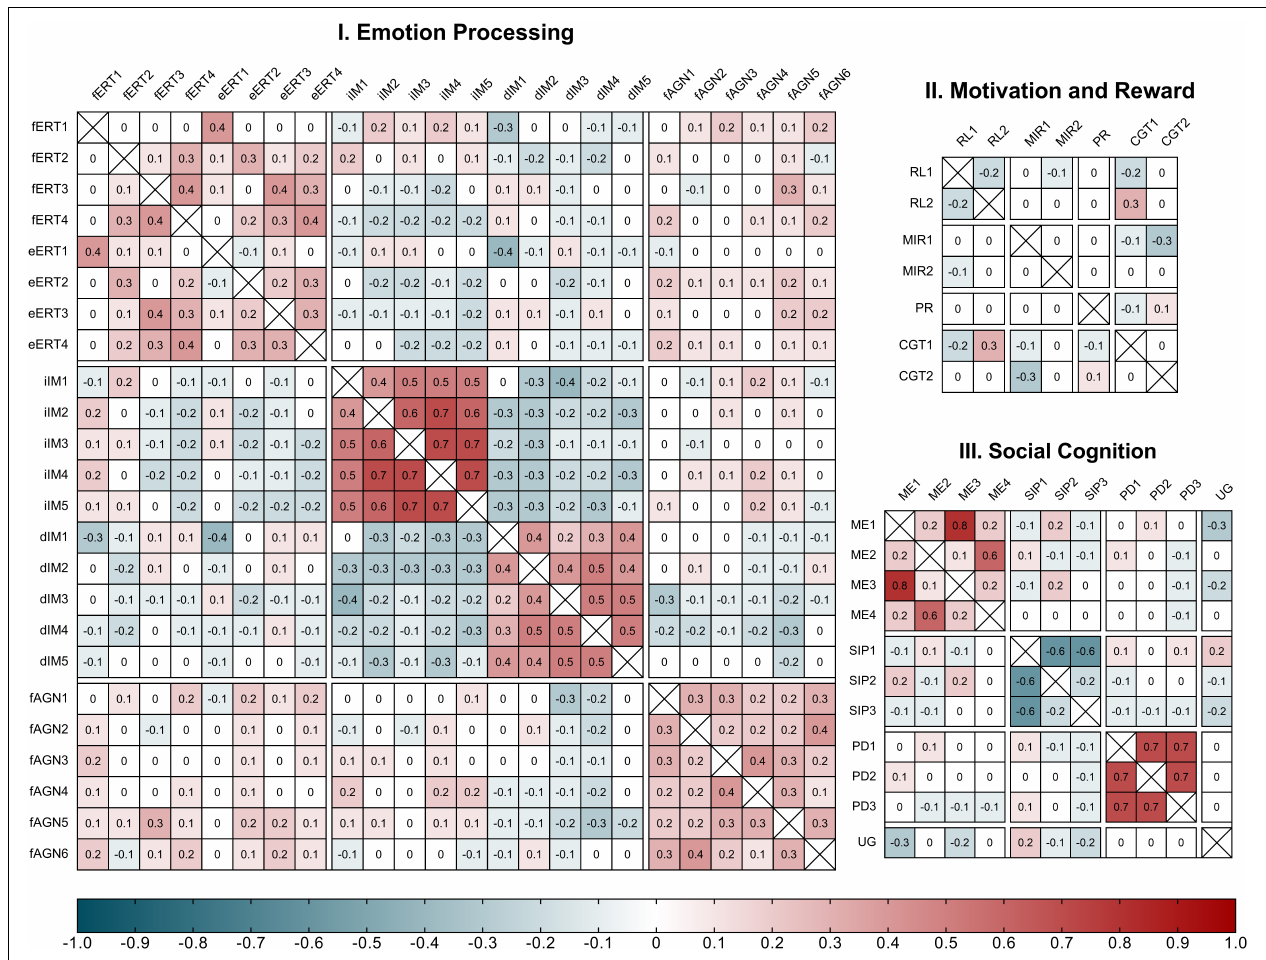
FIGURE 1 | Spearman’s Rank Correlations for EMOTICOM outcomes within the three proposed cognitive domains. (I) Emotion Processing: fERT, face Emotion Recognition Task; fERT1, hit rate for happy; fERT2, hit rate for sad; fERT3, hit rate for angry; fERT4, hit rate for fearful. eERT, eyes Emotion Recognition Task; eERT1, hit rate for happy; eERT2, hit rate for sad; eERT3, hit rate for angry; eERT4, hit rate for fearful. iIM, increase Emotional Intensity Morphing Task; iIM1, detection threshold for happy; iIM2, detection threshold for sad; iIM3, detection threshold for angry; iIM4, detection threshold for fearful; iIM5, detection threshold for disgusted. dIM, decrease Intensity Morphing Task; dIM1, detection threshold for happy; dIM2, detection threshold for sad; dIM3, detection threshold for angry; dIM4, detection threshold for fearful; dIM5, detection threshold for disgusted. fAGN, Face Affective Go/NoGo Task; fAGN1, d-prime for ‘happy/neutral’; fAGN2, d-prime for ‘happy/sad’; fAGN3, d-prime for ‘neutral/happy’; fAGN4, d-prime for ‘neutral/sad’; fAGN5, d-prime for ‘sad/happy’; fAGN6, d-prime for ‘sad/neutral.’ (II) Motivation and Reward: RL, Reinforcement Learning Task; RL1, learning rate alpha for win condition; RL2, learning rate alpha for loss condition. MIR, Monetary Incentive Reward Task; MIR1, reaction time for win condition; MIR2, reaction time for loss condition. PR, Progressive Ratio Task. aCGT, adapted Cambridge Gambling Task; aCGT1, risk adjustment for win condition; aCGT2, risk adjustment for loss condition. (III) Social Cognition Domain: ME, Moral Emotions Task; ME1, guilt for agent; ME2, guilt for victim; ME3, shame for agent; ME4, shame for victim. SIP, Social Information Preference Task; SIP1, proportion thoughts; SIP2, proportion faces; SIP3, proportion facts. UG, Ultimatum